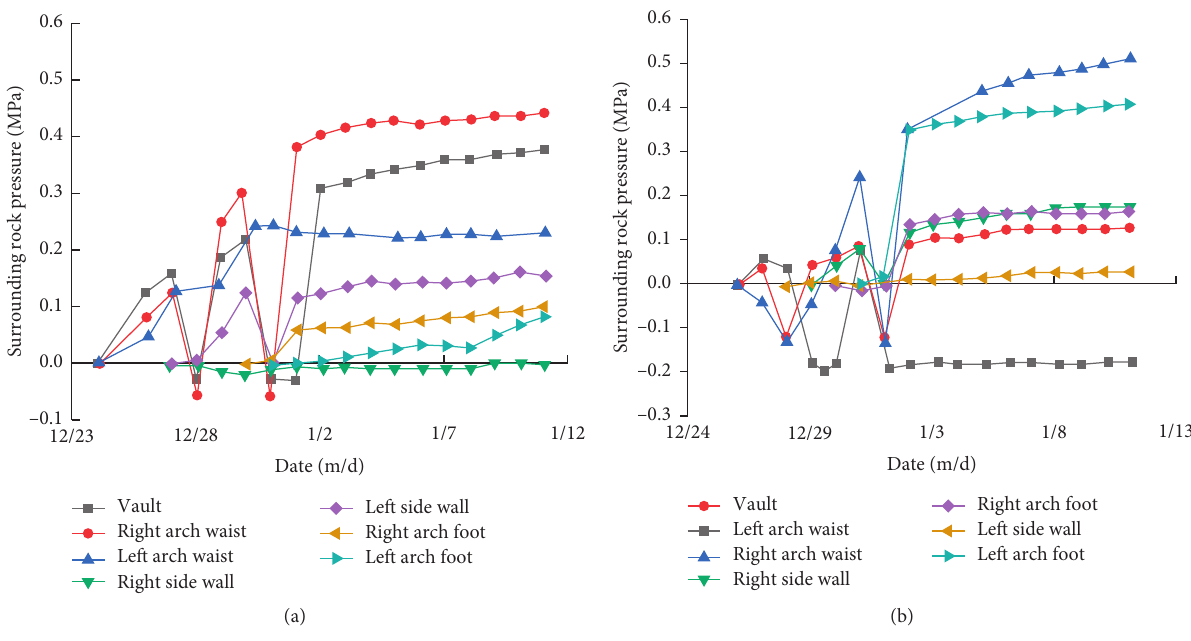
Figure 14: Time-history curves of surrounding rock pressure. (a) DK390 +163. (b) DK390